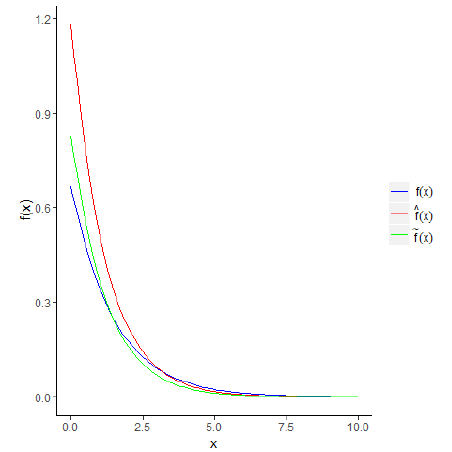
Figure 7 – MLE and UMVUE of sampled